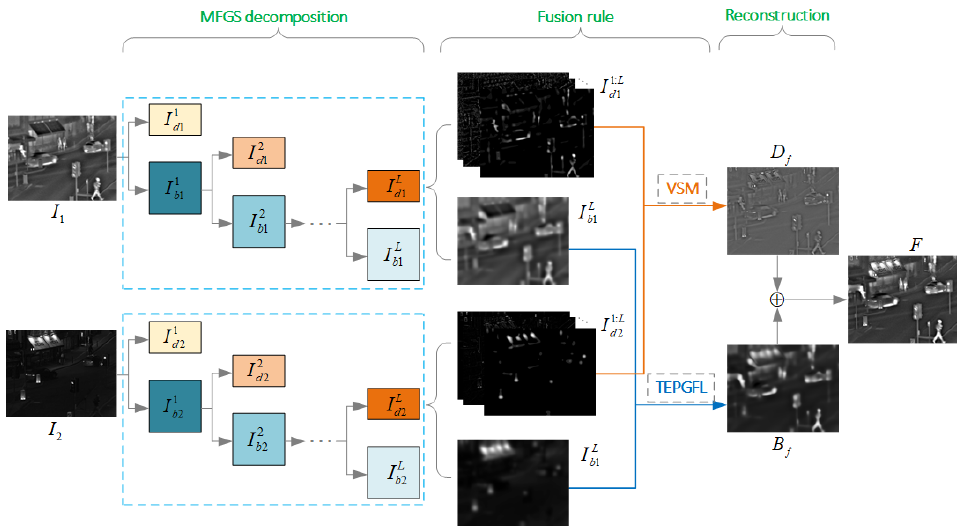
Figure 4. The MFGS fusion framework based on TEPGFL and VSM fusion strategies. Source images are decomposed into a series of detail layers ( I 1: L (TEPGFL and VSM), the final fused image F is reconstructed by combining the fused detail layer ( D f ) and base layer ( B f